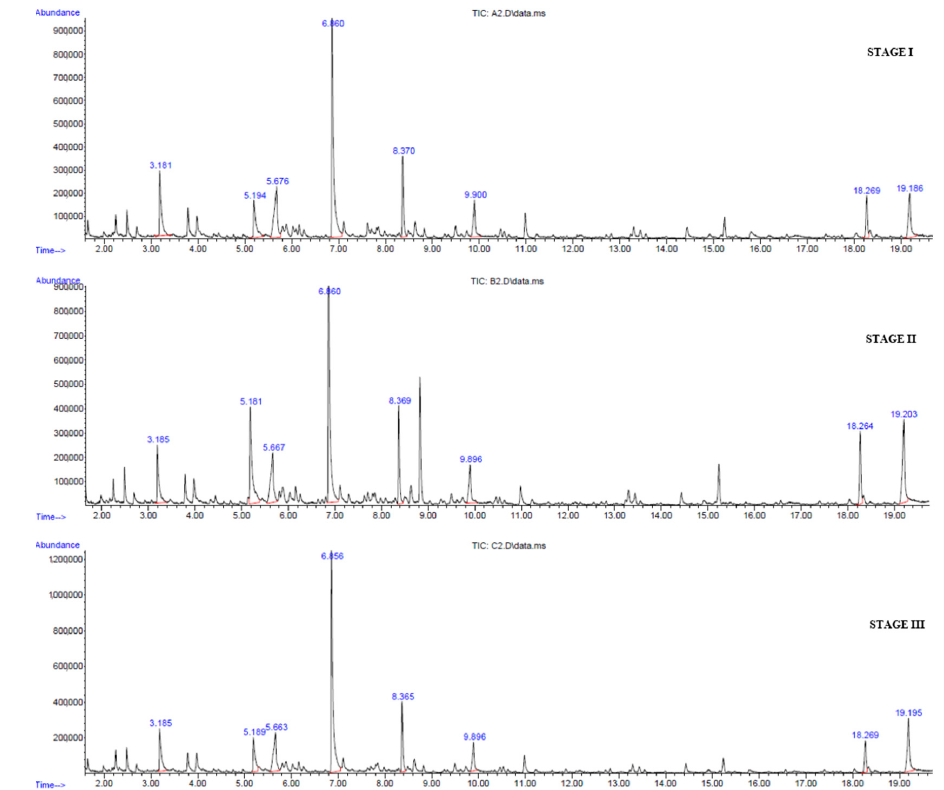
Figure 2. Profile of volatile compounds of the Aloe vera flowers at maturity stages I, II, and III. 1: 2-hexenaldehyde; 2: benzaldehyde; 3: 1-hexanoic acid; 4: benzyl alcohol; 5: 1-nonanal; 6: octanoic